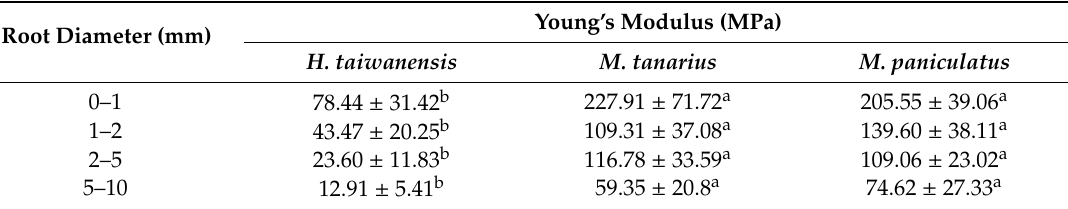
Table 11. Means ± standard deviations of root’s Young’s modulus of different root diameter classes for the three species studied.